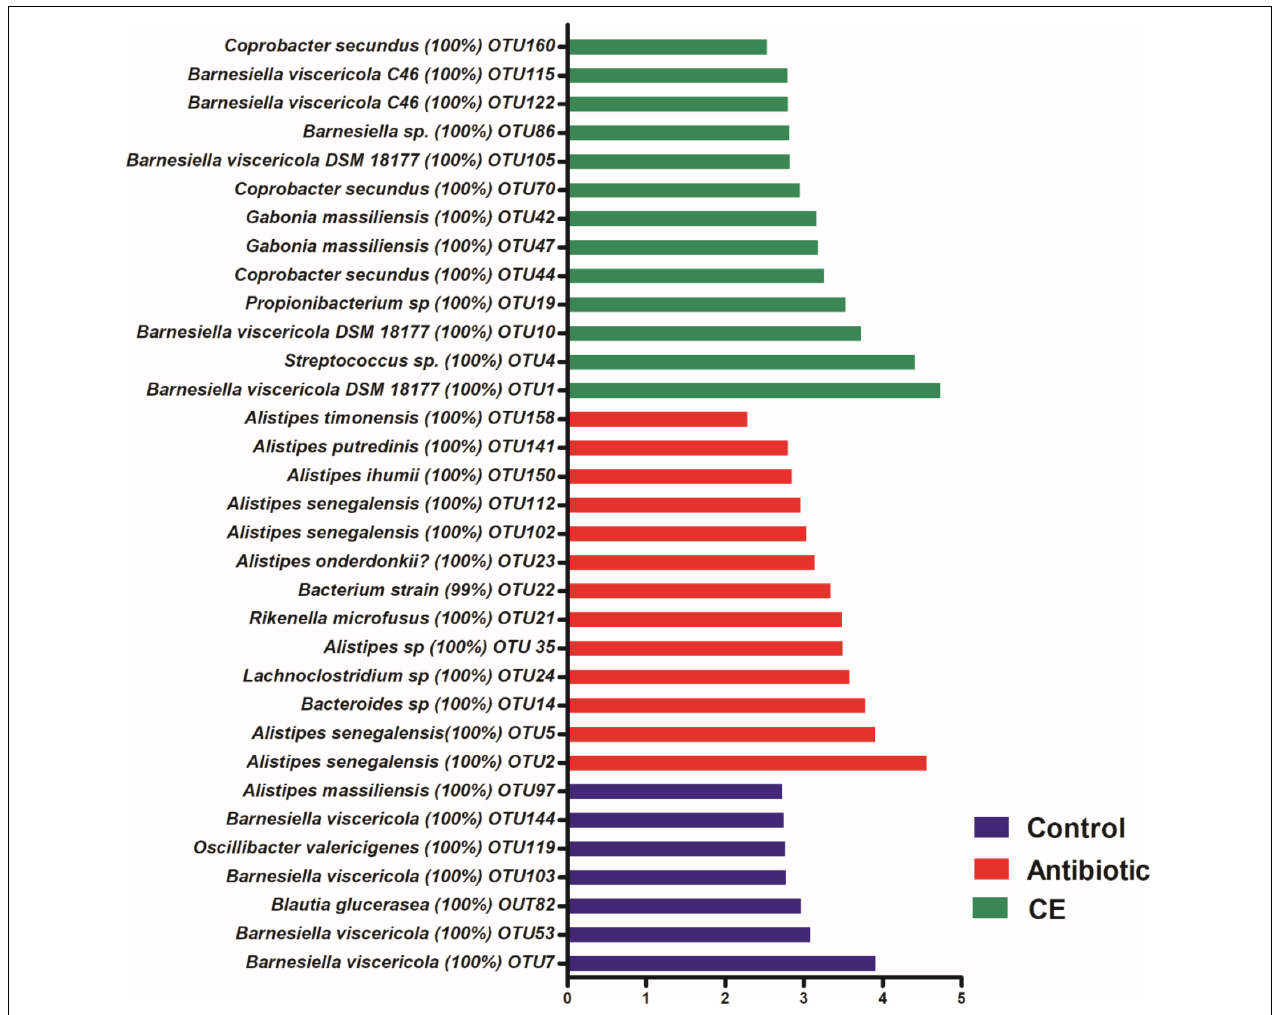
FIGURE 3 | Significantly changed bacterial OTUs in the cecal digesta by citrus extract treatments, as revealed by LEfSe analysis. Only an LDA score of > 2 was considered significant. CE, citrus extract; OTUs, operational taxonomic units; LDA, linear discriminant analysis; LEfSe, LDA effect